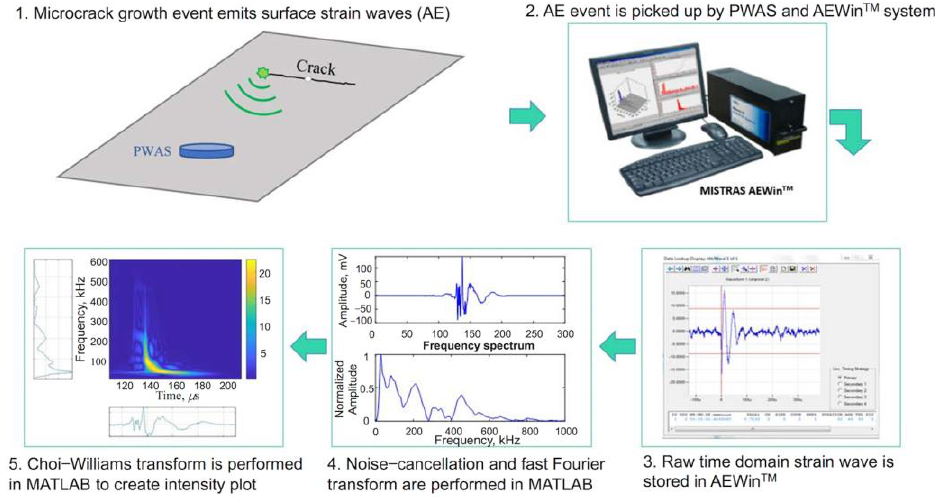
Figure 10. Flowchart of acoustic emission signal processing from microcrack growth event to the time–frequency intensity plot of Choi–Williams transform [101].